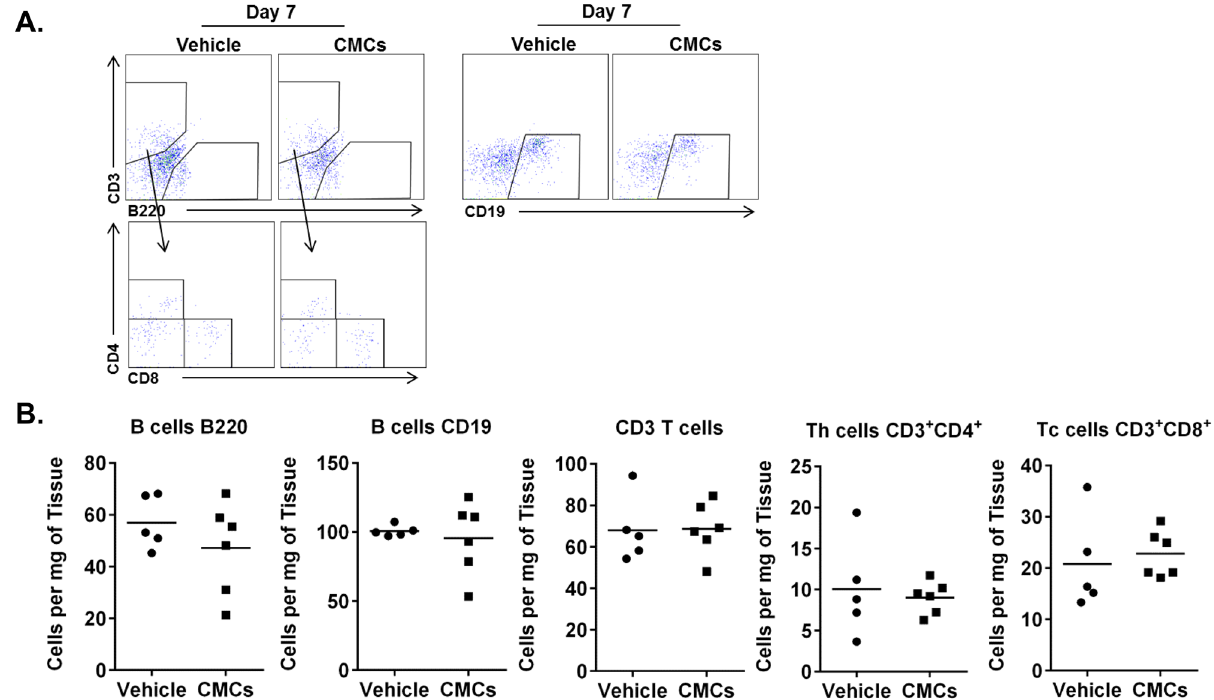
Figure 5. Intramyocardial injection of CMCs has no effect on B and T cell number in vivo. CMCs (5 × 10 5 ) were intramyocardially injected in the mouse hearts 2 d after MI. Seven days later, hearts were harvested and B and T cells were detected with flow cytometry ( A ), and quantified ( B ). Number of cells shown as mean; sham n = 5, MI n = 6; ( unpaired t test